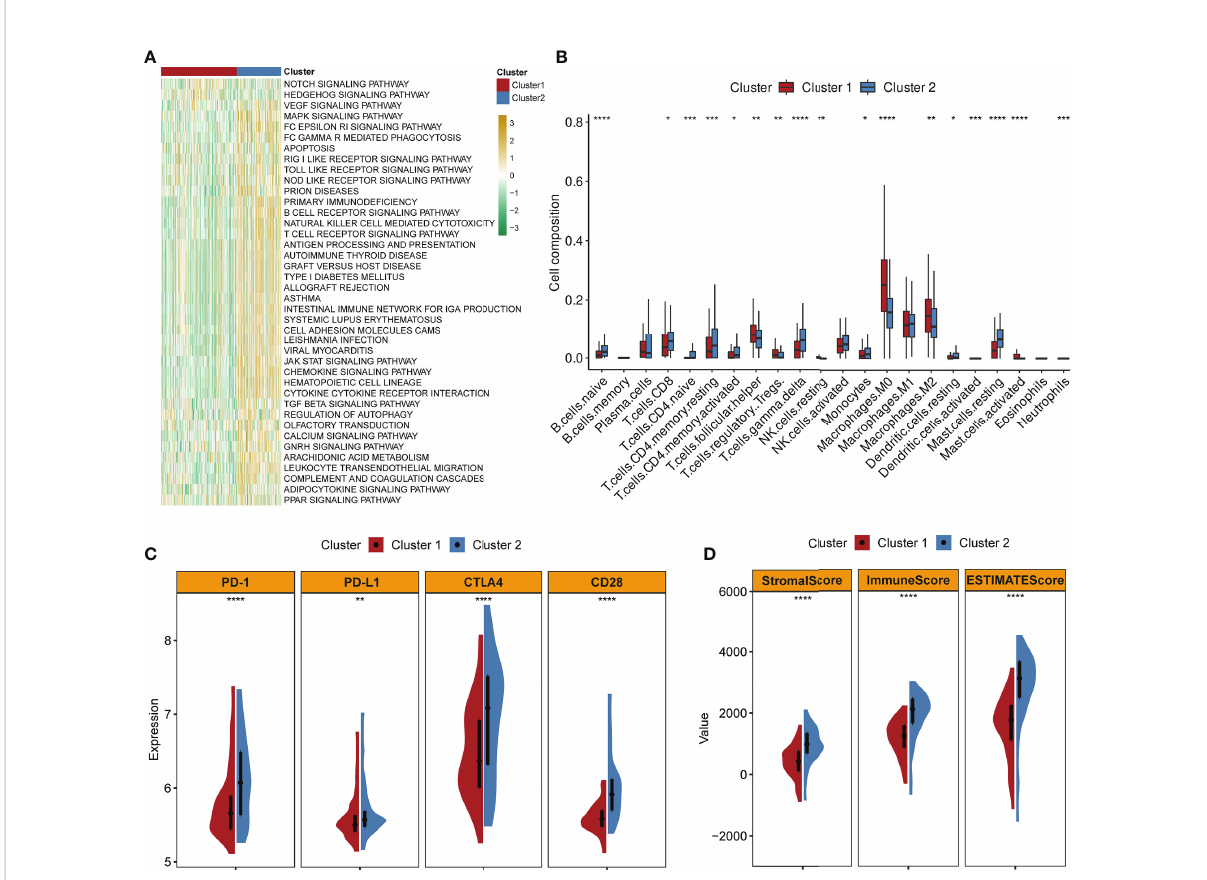
FIGURE 3 Correlations of clusters with TME characteristics ( fi rebrick: cluster 1; steel blue: cluster 2; ****, ***, **, and * mean p < 0.0001, < 0.001, < 0.01, and < 0.05, respectively). (A) Heatmap of GSVA indicates difference in biological processes between two clusters (yellow: upregulated; green: downregulated). (B) Abundance of 22 immune cells in two clusters. (C) Violin plots of the expression levels of classical immune checkpoints in two clusters. (D) Violin plots of the TME scores in two